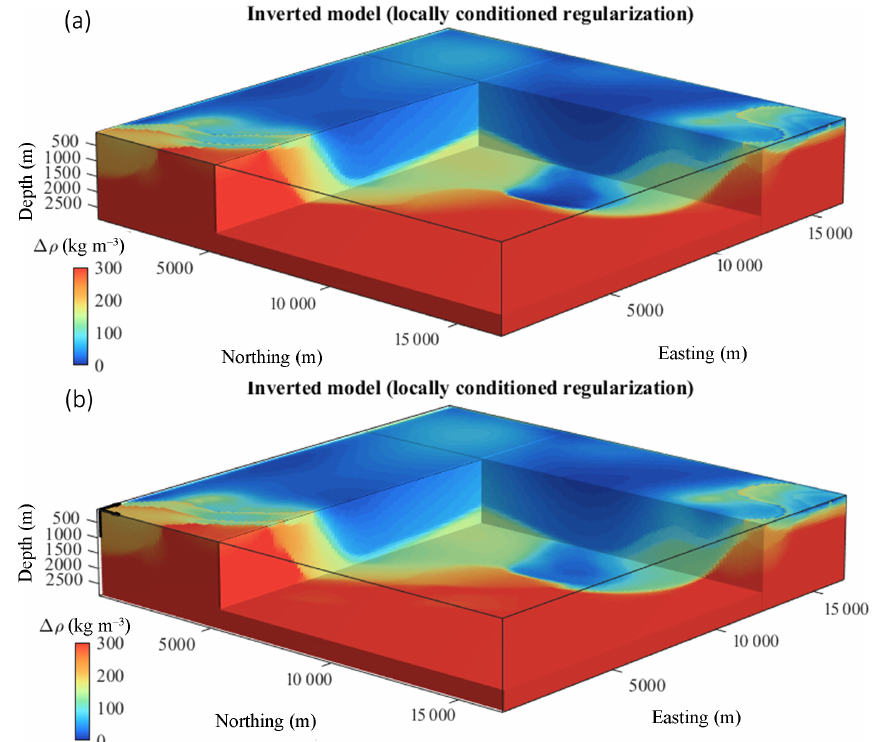
Figure 4. Comparison of inverted model using W H derived from a PGM considering the ghost unit (b) and without it (a) ; (a) is the inverse model obtained without bias in the PGM as per Fig. 2 and is shown here for comparison with (b)